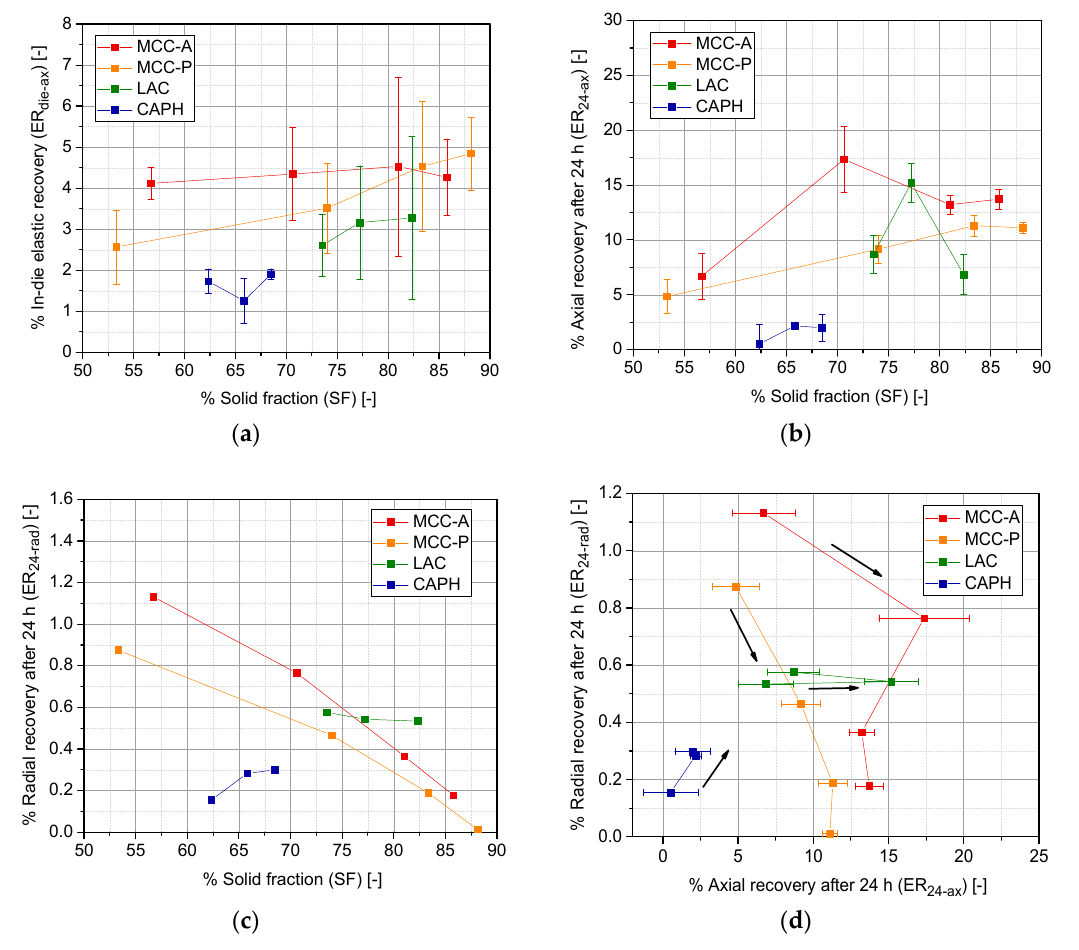
Figure 6. Elastic recovery after compaction of MCC-A/P, LAC, and CAPH granules: ( a ) In-die axial elastic recovery; ( b ) Axial recovery after 24 h; ( c ) Radial recovery after 24 h; ( d ) Axial vs. radial elastic recovery after 24 h (arrows pointing towards the direction of increasing solid fraction).